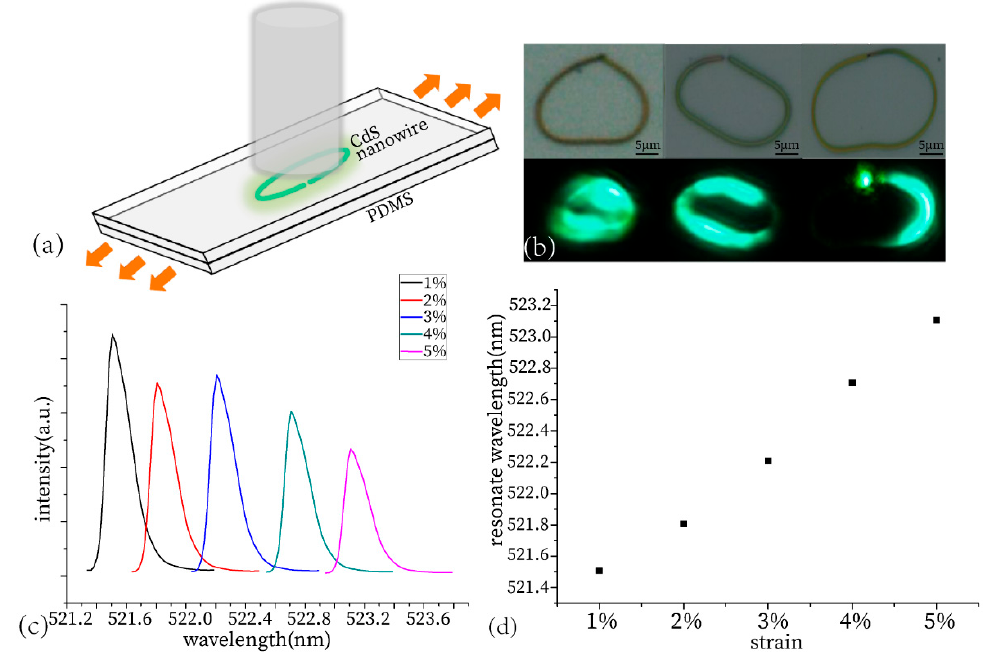
Figure 6. ( a ) Schematic diagram of test the packaged stress sensor. ( b ) Bright field and fluorescence picture under three different sets of deformation. ( c ) Spectral peak position map under different stresses. ( d ) Correspondence between the strain and peak positions.